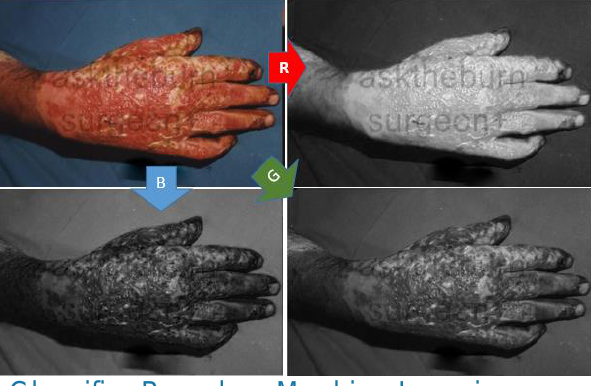
Fig. 7. An example of multi-color